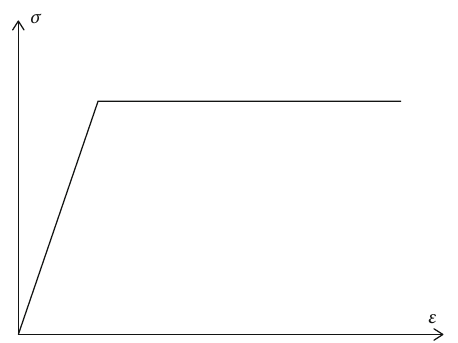
Figure 3: Ideal elastoplastic constitutive relationship [15].